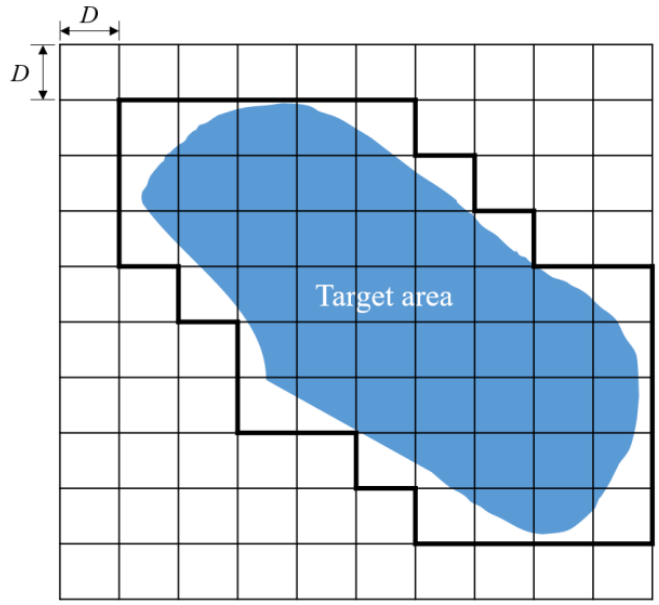
Figure 1. Grid map and target area.